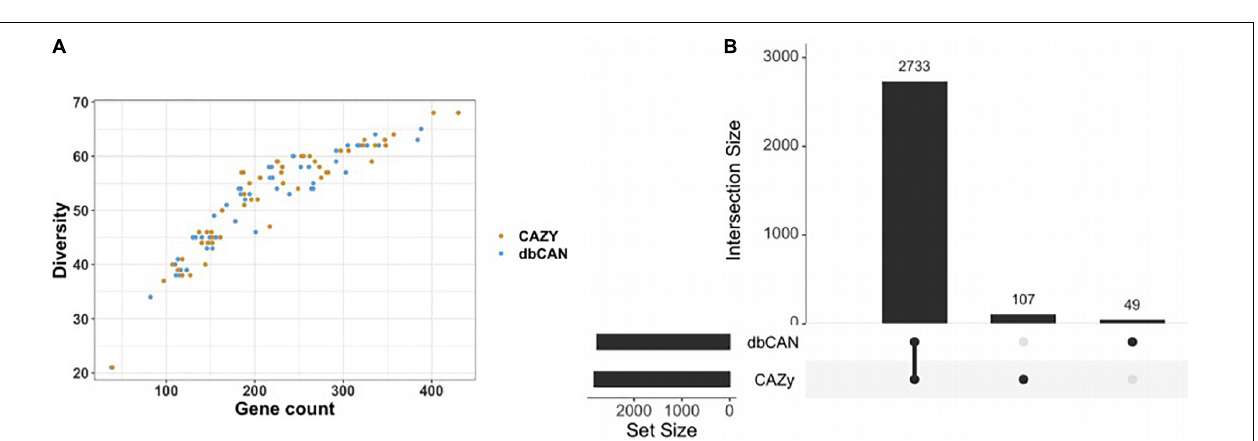
FIGURE 1 | FiberGrowth pipeline strategy and proof of concept. The different steps of the pipeline are shown, highlighting the iterations between computing and integration of microbiology data. The PUL models, once designed, can then be used to process genomes within minutes. See Prediction of Polysaccharide Utilization Loci Using FiberGrowth in “Materials and Methods” section for additional pipeline specifications.